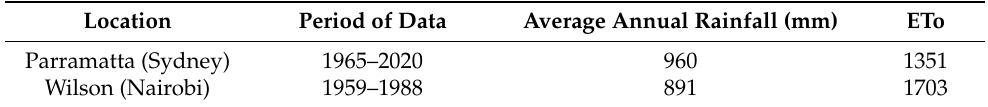
Table 1. Summary of selected climate